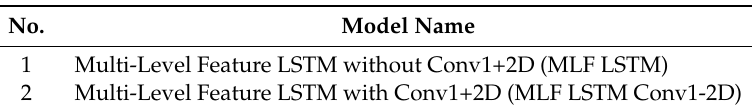
Table 4. List of the proposed models.